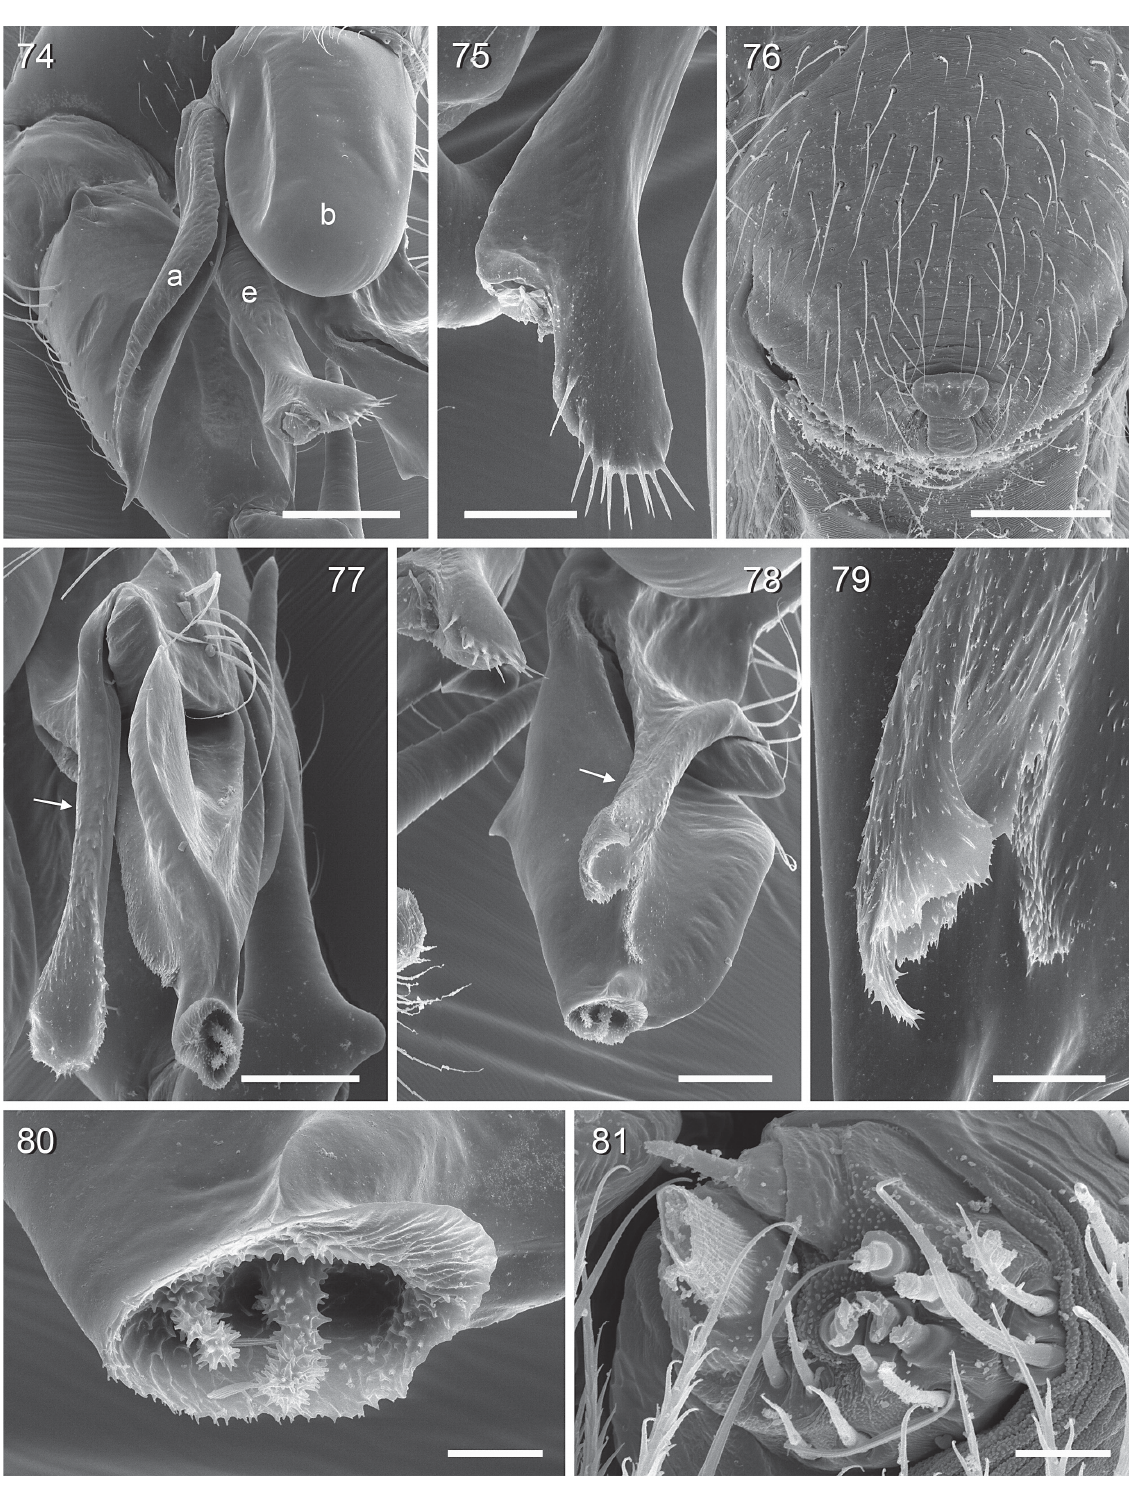
Figs 74–81. Panjange kubah Huber, sp. nov. (ZFMK Ar 14587–88). 74 . Left bulb, prolateral (slightly distal) view. 75 . Tip of left embolus. 76 . Epigynum, ventral view. 77–78 . Left procursus, dorso-distal and prolateral views (arrows point at distinctive membranous process). 79 . Membranous process of left procursus. 80 . Tip of left procursus, distal view. 81 . Female ALS. Abbreviations: a = appendix; b = genital bulb; e = embolus. Scale lines: 10 µm (81); 20 µm (80); 40 µm (79); 80 µm (75); 100 µm (77–78); 200 µm (74,